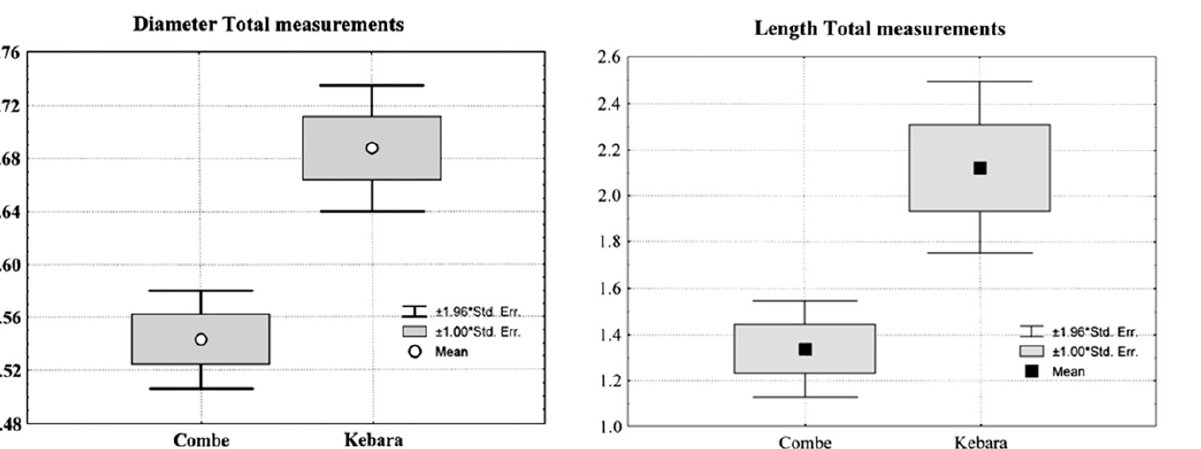
Figure 3. Combe Grenal IV. ( A ): (picture 308), tartar bacteria at 20,000 SEM magnification. ( B ): Kebara Figure 3. 2 (picture 603), tartar bacteria at 5000 SEM magnification.